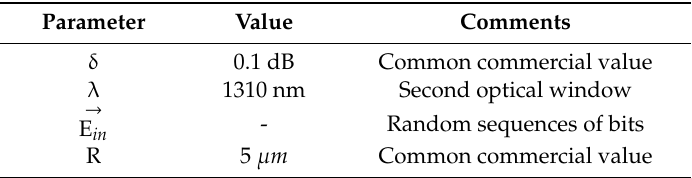
Table 2. Selected values for the experimental